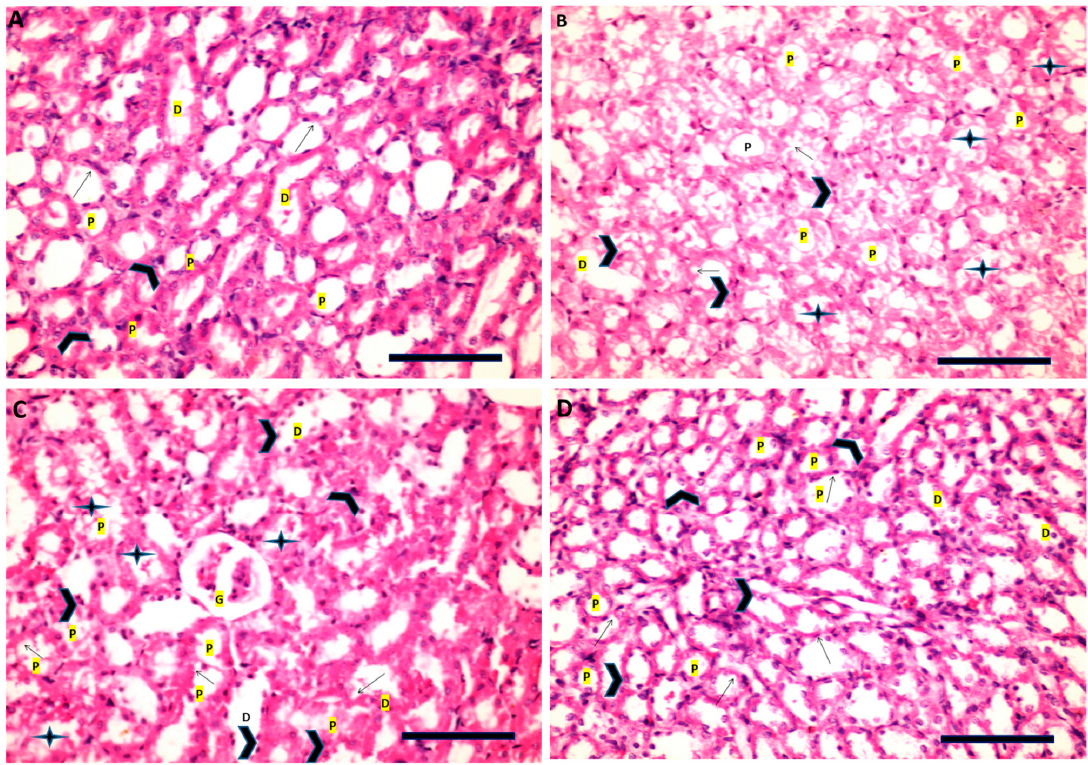
Figure 10. Renal tissues as stained by H&E (scale bar, 100 μ m) for STZ rats after administration of rapamycin or after fasting. ( A ) Control rats are having normal architecture of proximal tubules (P) with intact brush border (arrow), and vesicular nuclei (arrowhead) of the epithelium lining, intact epithelium of the distal convoluted tubules (D) (H&E, ×100). ( B ) STZ rats having atrophied renal proximal (P) and distal (D) tubules with pyknotic nuclei (arrowhead) and loss of brush border (arrow) (H&E, ×40). ( C ) STZ rats that were administered rapamycin showing diffuse atypical glomerules (G), necrotic vacuolated epithelial cells of renal proximal (P) and distal (D) tubules with some hyaline cast in the lumen (star), pyknotic nuclei (arrowhead) and loss of brush border (arrow) (H&E, ×100). ( D ) Fasting STZ rats showing recovery of proximal tubules (P) with normal brush border (arrow), and vesicular nuclei (arrowhead) of the epithelium lining, intact epithelium of the distal convoluted tubules (D) (H&E, ×100).